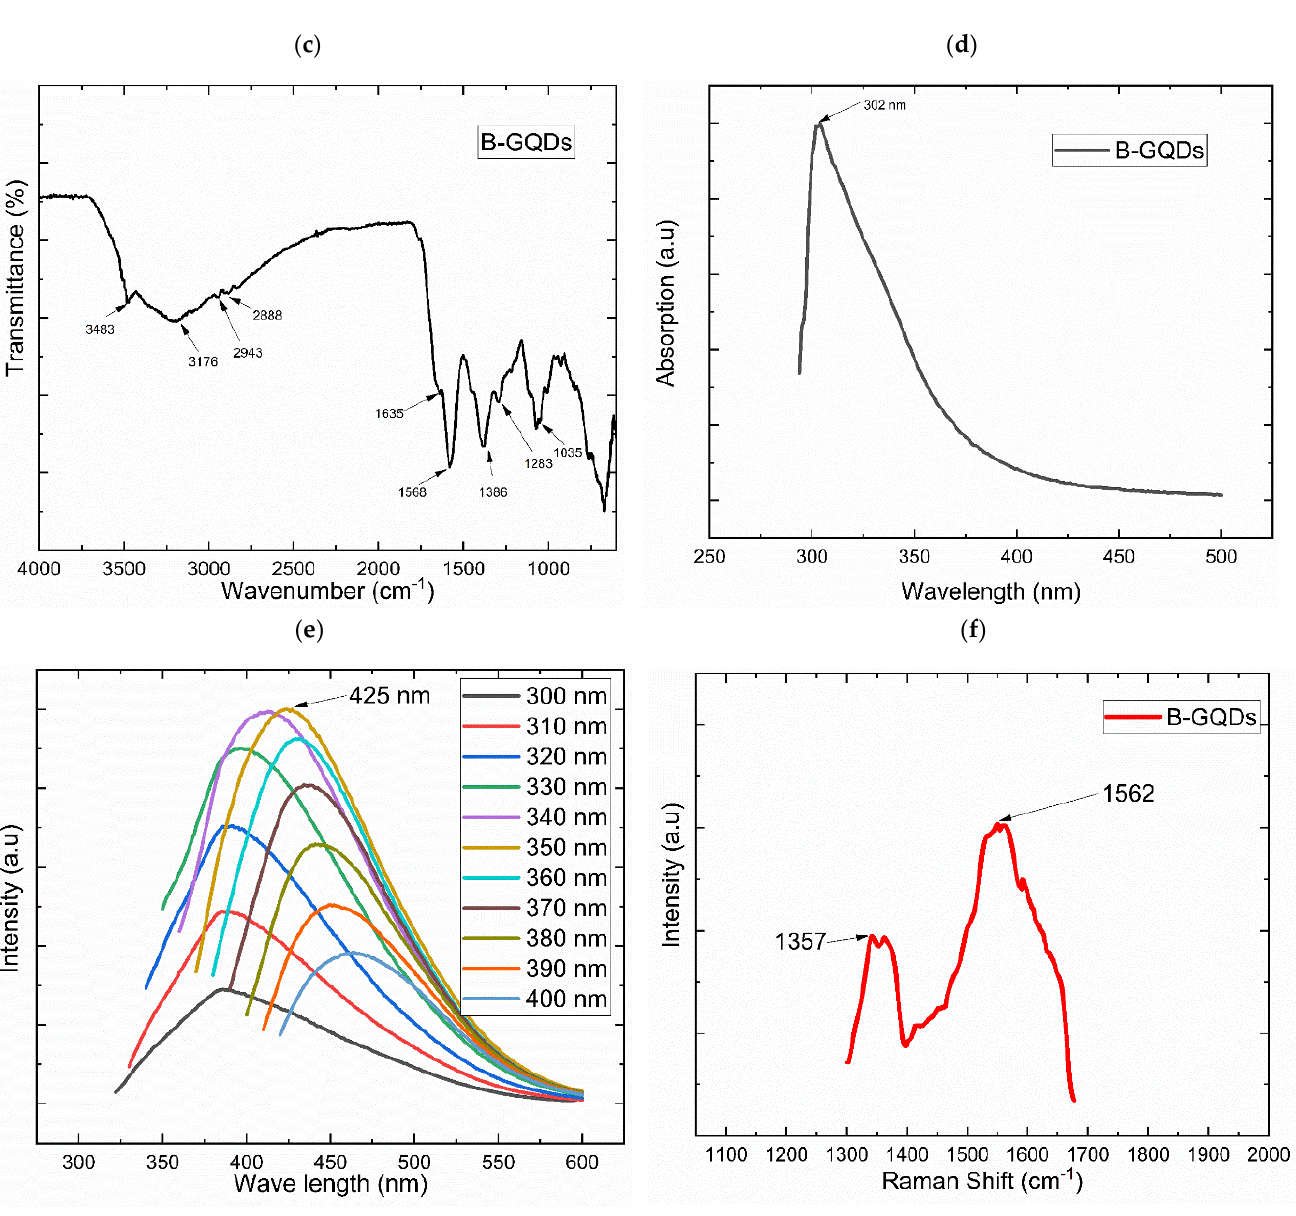
Figure 5. ( a ) Transmission electron microscopy image of B-GQDs; ( b ) the size distribution of B-GQD particles; ( c ) FTIR spectrum of B-GQDs; ( d ) B-GQD Raman spectrum; ( e ) B-GQD UV–vis spectrum; ( f ) PL spectrum of